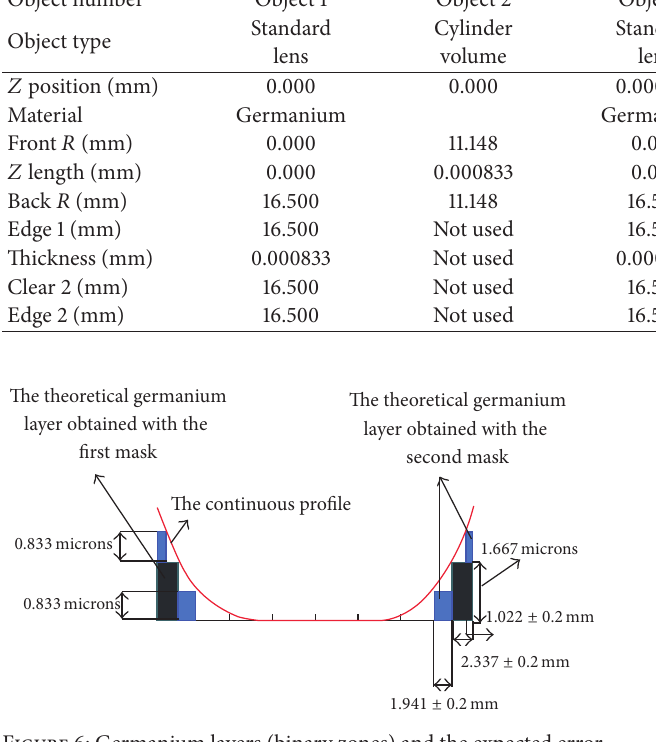
Figure 6: Germanium layers (binary zones) and the expected error in their width.